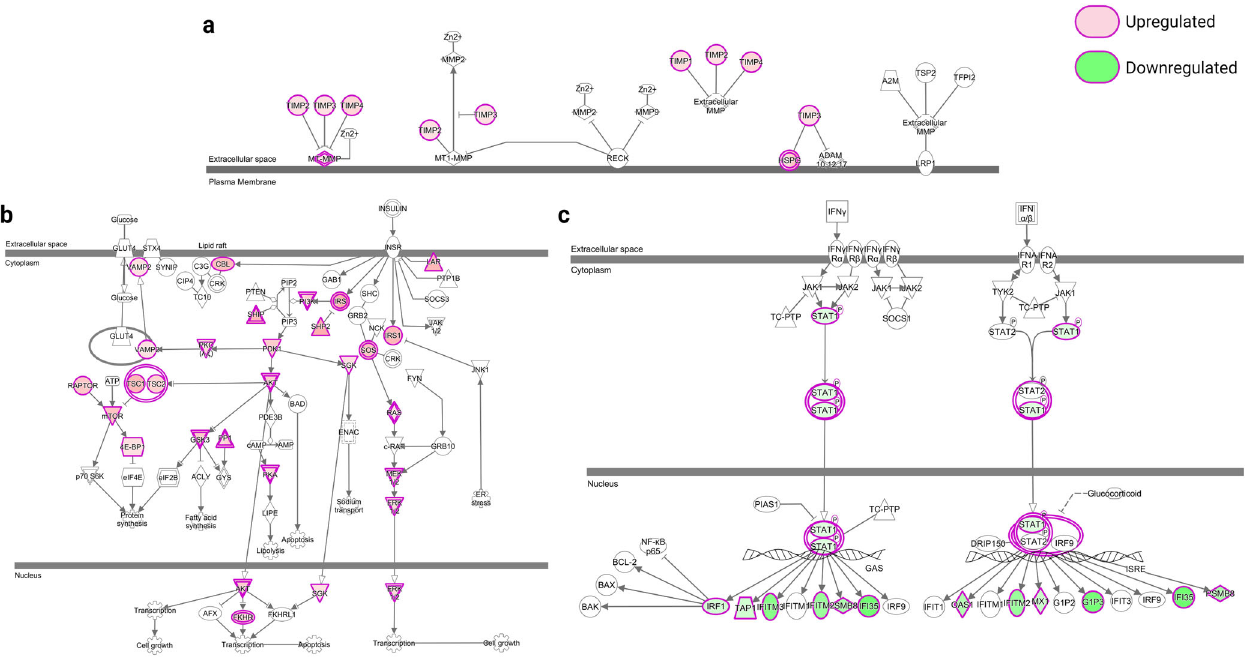
Fig. 4 Gene expression changes in the representative pathway of each group. a Inhibition of matrix metalloproteases (enriched in Group 1). b Insulin receptor signaling (enriched in Group 2). c Interferon signaling (enriched in Group 3). Downregulated genes are indicated with green shading and upregulated genes in